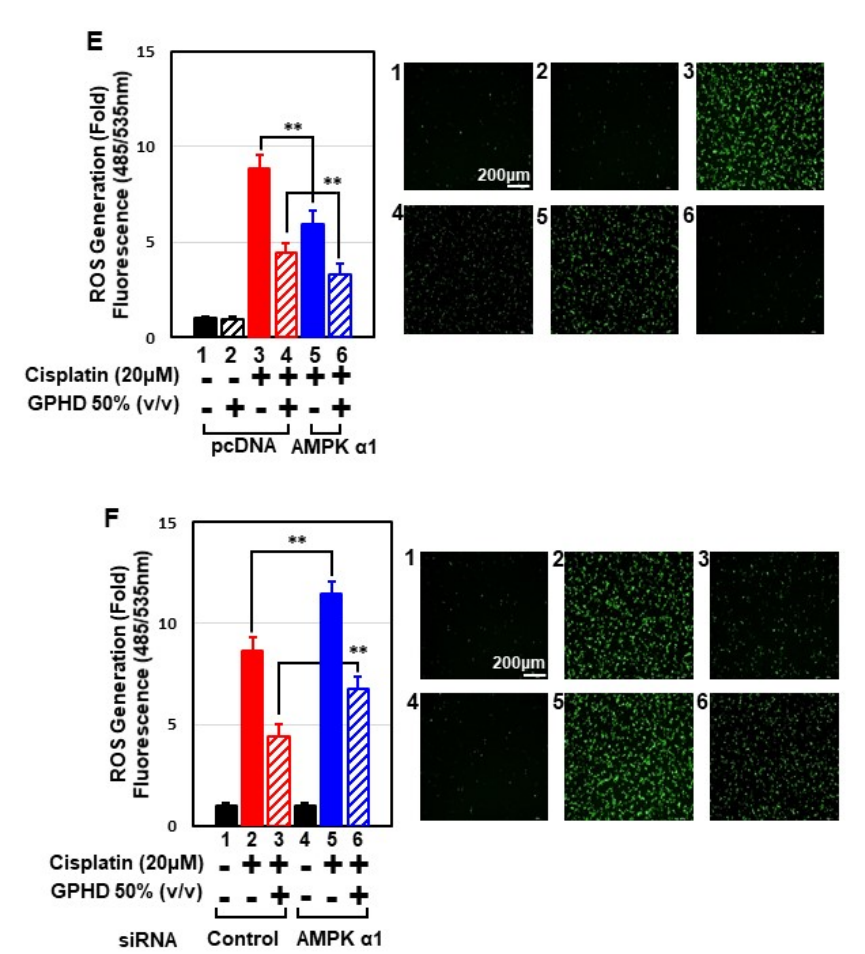
Figure 4. GPHD suppresses cisplatin ‐ generated ROS and ROS ‐ induced apoptosis via AMPK α 1, a cellular anti ‐ oxidant factor. HEK293 cells were treated with cisplatin (20 μ M) and/or NAC (10 μ M) for 24 h. Thereafter, intracellular ROS levels were measured ( A ), and FACS analysis of 7 ‐ AAD and annexin V double ‐ positive cells ( B ), Western blot analysis ( C ), and luciferase reporter assays for AMPK α 1 promoter activity ( D ), were performed. HEK293 cells were transfected with an expression vector for HA ‐ tagged AMPK α 1 ( E ) or siRNA for AMPK α 1 ( F ), then treated with cisplatin and/or GPHD for 24 h, after which cellular ROS levels were measured. The results shown are representative of the three independent experiments. p ‐ value < 0.05 was considered statistically significant; individual p ‐ values (* p < 0.05; ** p < 0.01) are indicated in figures.